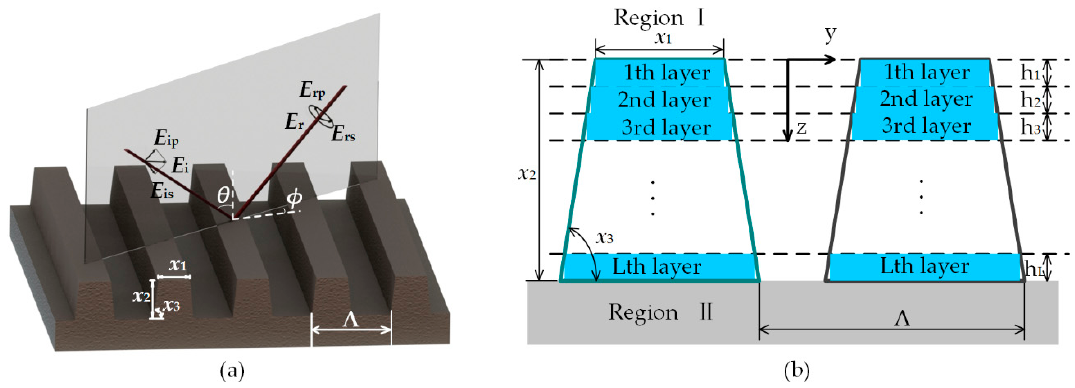
Figure 2. ( a ) Representation of polarized light incidence for a one-dimensional grating; ( b ) layers division in inverse modeling using rigorous coupled-wave analysis.